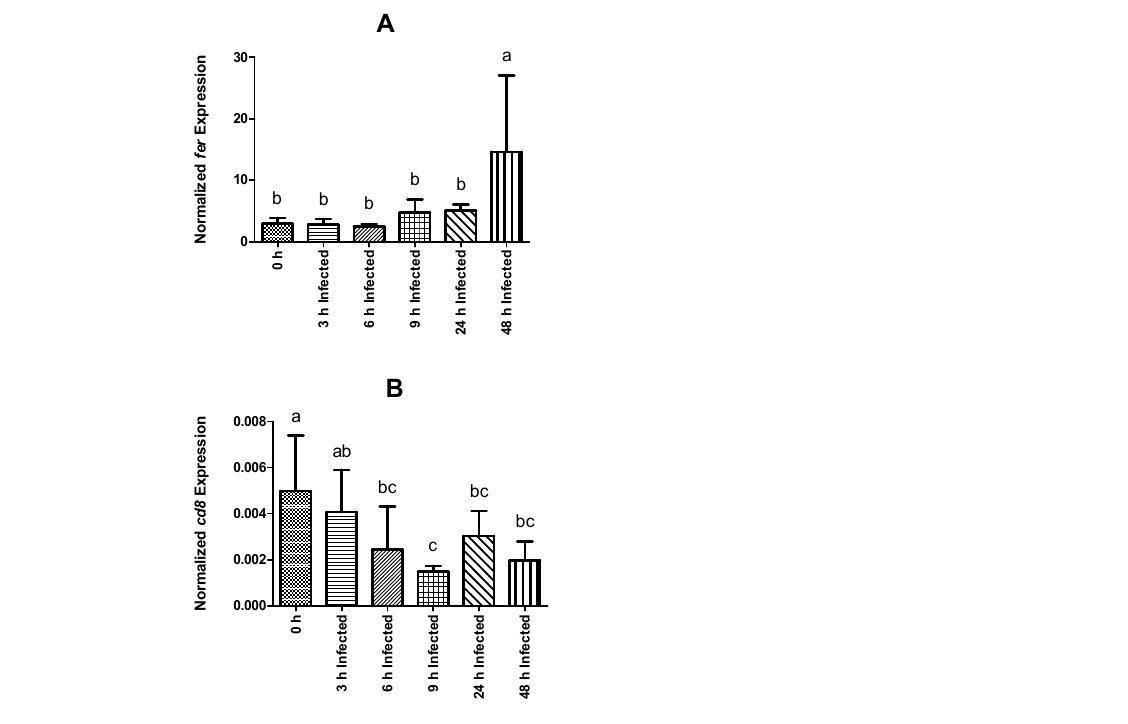
Figure 5. Normalized gene expression ( ∆∆ Cq) of rainbow trout sampled before (0 h) or 3, 6, 9, 24, and 48 h post-intraperitoneal infection with Y. ruckeri (means ± SD, n = 6). ( A ) fer (ferritin); ( B ) cd8 (T-cell surface glycoprotein CD8 alpha precursor). Letters denote significant differences between bio-groups. In all cases, a statistical threshold of p ≤ 0.05 was used. The reference gene ef-1 α (elongation factor-1 alpha) was used for normalization.